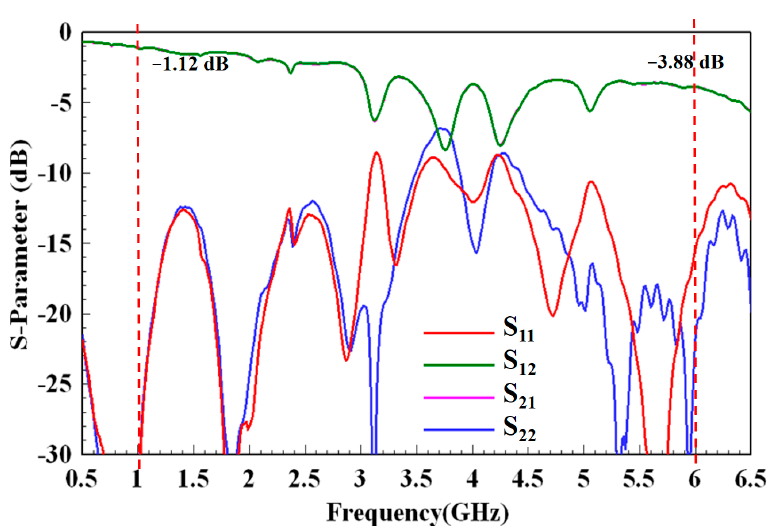
Figure 9. Measurement result of the preliminary test structure.